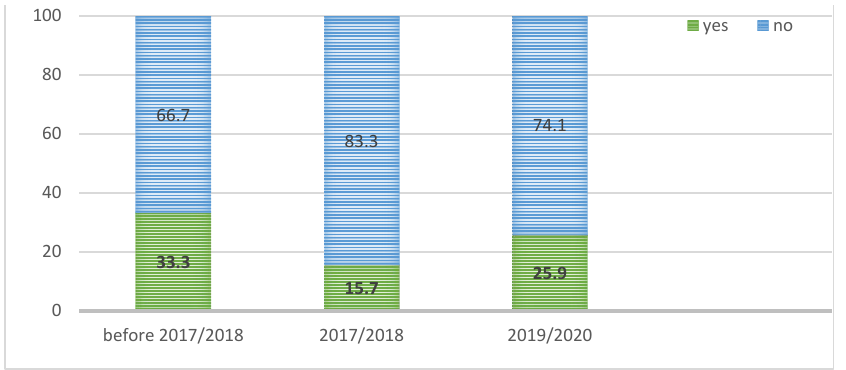
Figure 1. Vaccination history among the surveyed patients by the epidemic season; ( n = 108). Patients vaccinated during the 2018/2019 epidemic season were asked about the rea- sons for being vaccinated. The results are presented in Figure 2. The most commonly re- ported reason was the recommendation of a family physician (46.3%), followed by the vaccination reimbursement (28.7%), recommendation of a vaccinated friend/family mem- ber (12.9%), or media campaign (12.0%). It was a multiple-choice question.